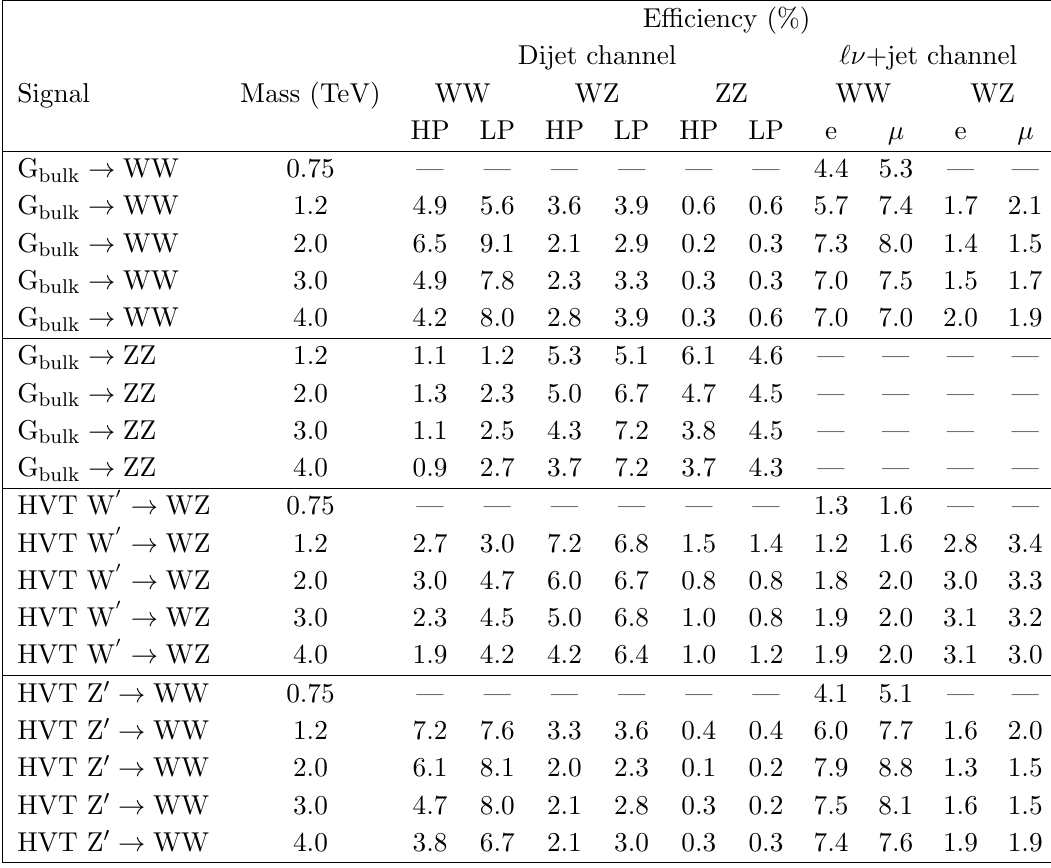
Table 6 . Summary of signal e(cid:14)ciencies for all analysis channels and all signal models. The quoted e(cid:14)ciencies are in percent, and include the branching fractions of the two vector bosons to the (cid:12)nal state of the analysis channel, e(cid:11)ects from detector acceptance, as well as reconstruction and selection e(cid:14)ciencies. Values are not indicated for categories and masses where the analysis channel has no